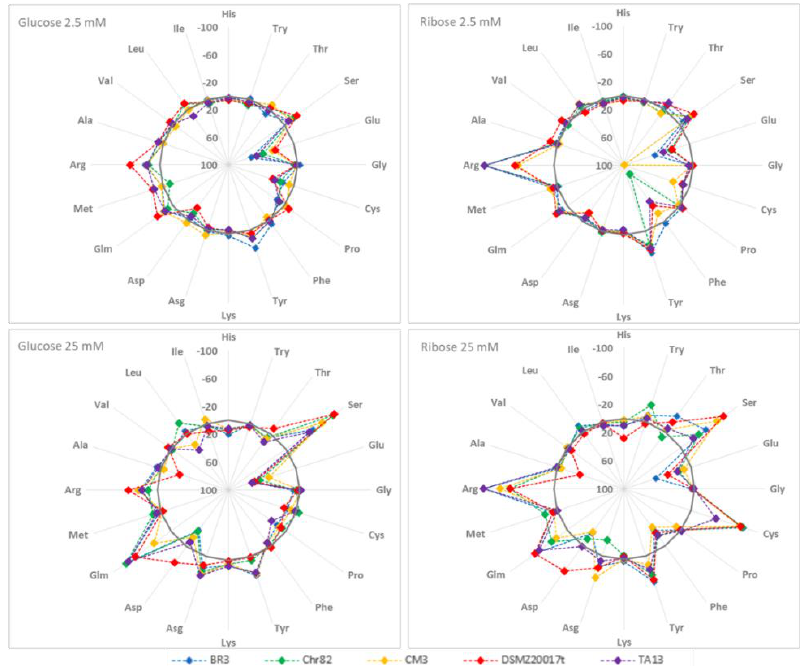
Figure 1. Percentage variation with respect to the initial concentration of amino acids after 24 h of incubation of the five L. sakei strains in the defined media with different sugar amounts. Negative values mean amino acid consumption, and positive values mean amino acids accumulation, while the continuous grey line represents the interface (0%).